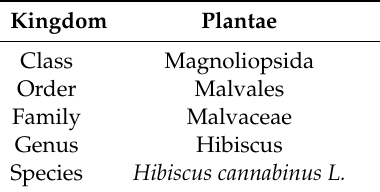
Table 1. Kenaf plant (cid:48) s